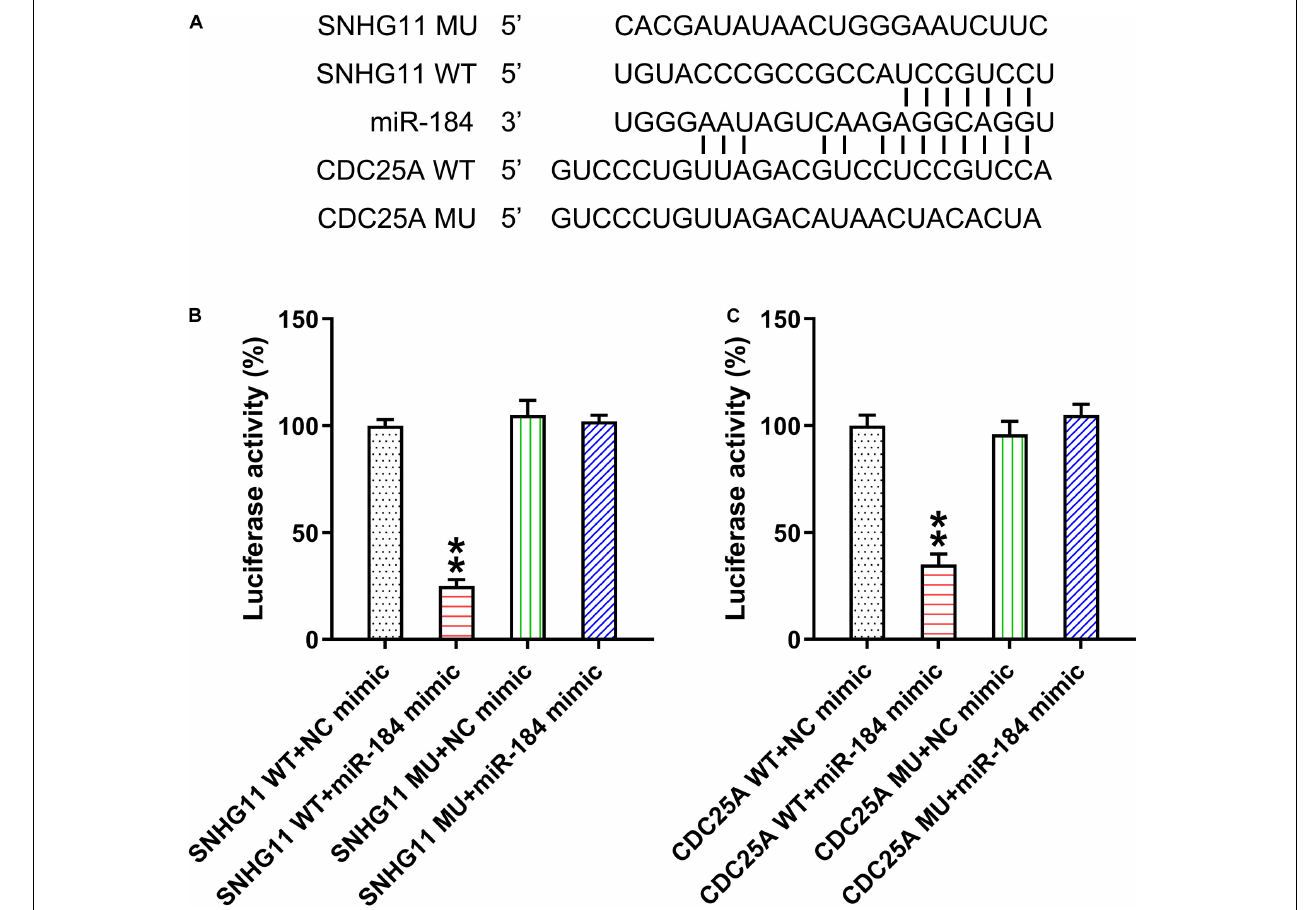
FIGURE 1 | LncRNA SNHG11 targeted miR-184 and miR-184 targeted CDC25A. (A) Illustration of the conserved SNHG11-binding motifs in miR-184, and the conserved miR-184-binding motifs in CDC25A 3 (cid:48) -UTR. (B,C) Luciferase functions were assessed with luciferase reporter products consisting of WT or MU copy of SNHG11 and CDC25A after miR-184 mimic transfection in HEK293T cells with Renilla luciferase as a reference. These data are shown as average ± SD . ** P < 0.01 vs. indicated groups (hereinafter